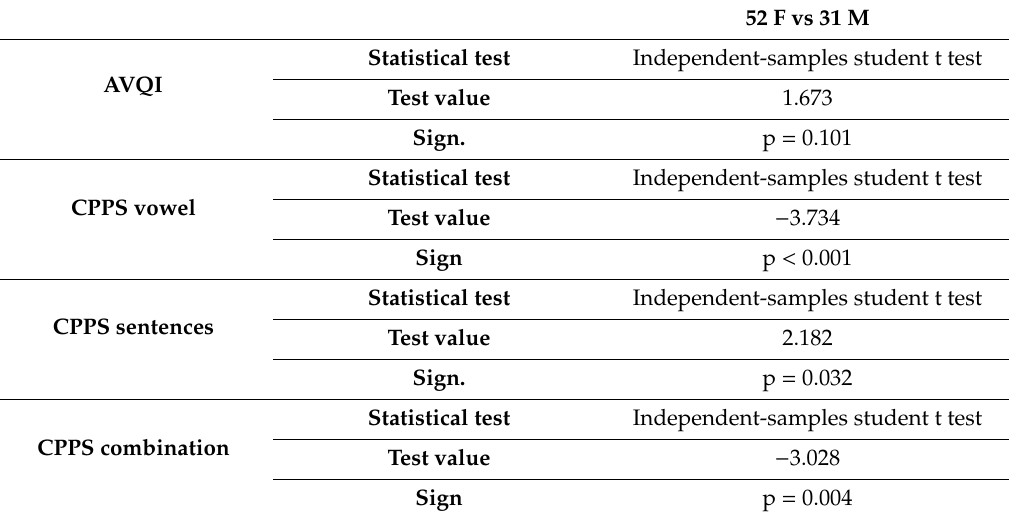
Table 3. Gender e ff ect of AVQI and